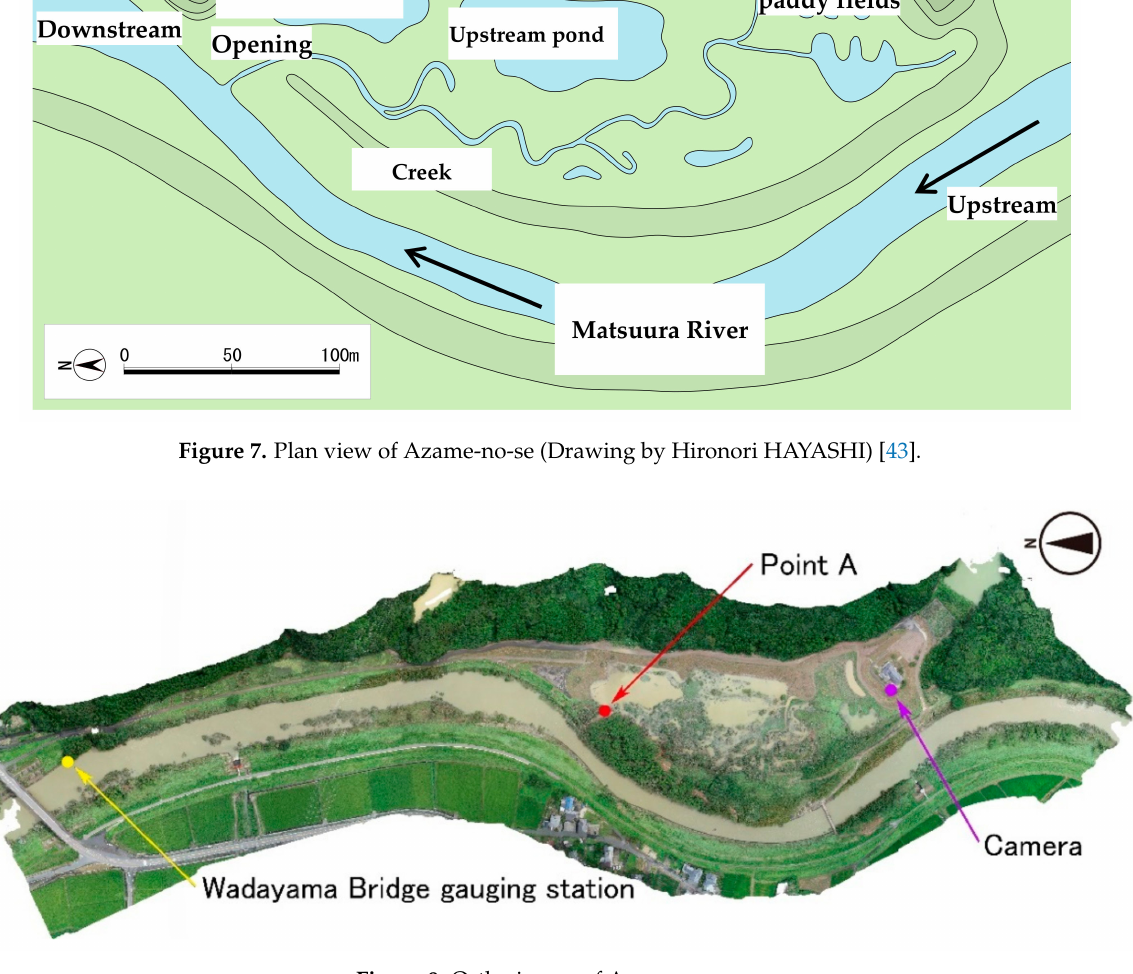
Figure 8. Ortho image of